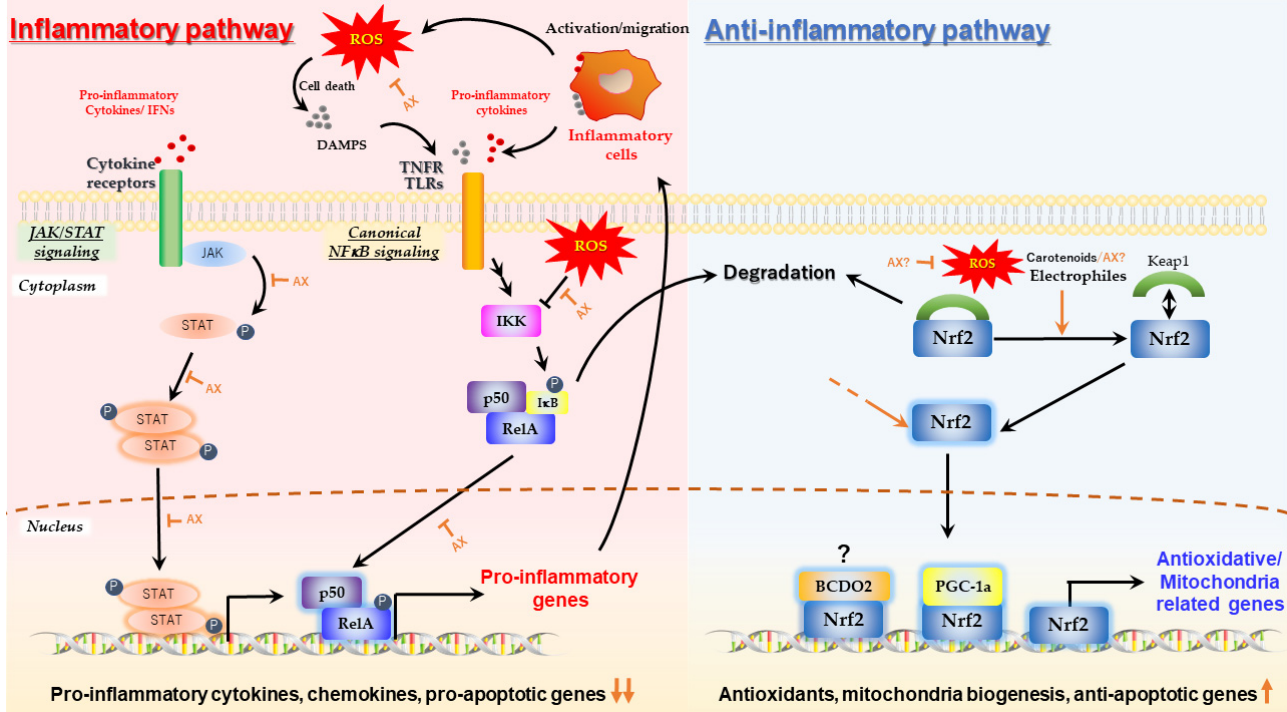
Figure 3. AX partially induces the antioxidant defense system while inhibiting the ROS-mediated inflammatory signaling pathway. AX inhibits ROS-mediated activation of canonical NF κ B signaling and related signals such as JAK/STAT3. Con- sequently, the induction of pro-inflammatory cytokine gene expression is suppressed, resulting in attenuation of inflam- matory signals. On the other hand, AX produces partial activation of Nrf2 via dissociation of Nrf2/Keap-1 by electrophiles, and/or other pathways. Consequently, antioxidant enzymes are induced and act in an anti-inflammatory function in vivo . Thus, AX suppresses the exacerbation cycle of chronic inflammation and shifts the cycle toward improvement. The regu- lation of these inflammation-related signaling pathways by AX involve a mixture of acute-phase responses to AX that result from ROS scavenging, modulation of phosphorylation and protein modifications related to the regulation of intra- cellular Redox balance, modulation of adaptor protein association with receptors, and the more chronic induction of gene expression mediated by these results. In this figure, lipid rafts and precise and detailed signal pathways are not shown to avoid complications. In particular, it has been reported that AX affects the points indicated by the orange arrows. This figure was adapted from the reference